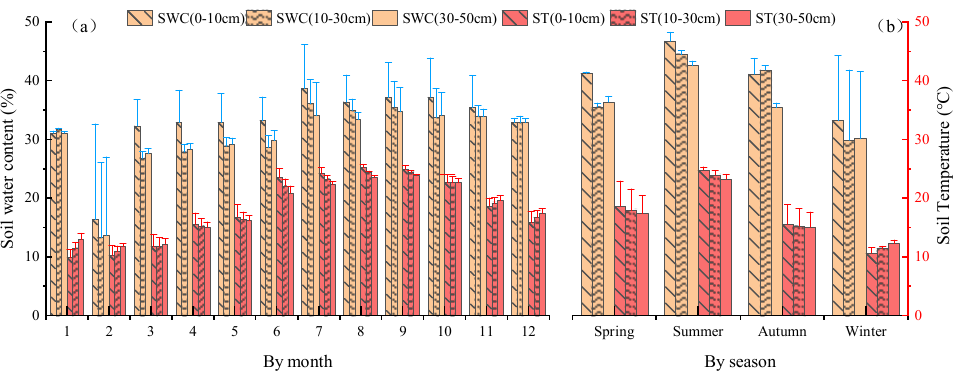
Figure 5. Soil water content and soil temperature in different soil layers at sampling site from January to December 2020. ( a ) By month. ( b ) By season. Blue and red line represents standard